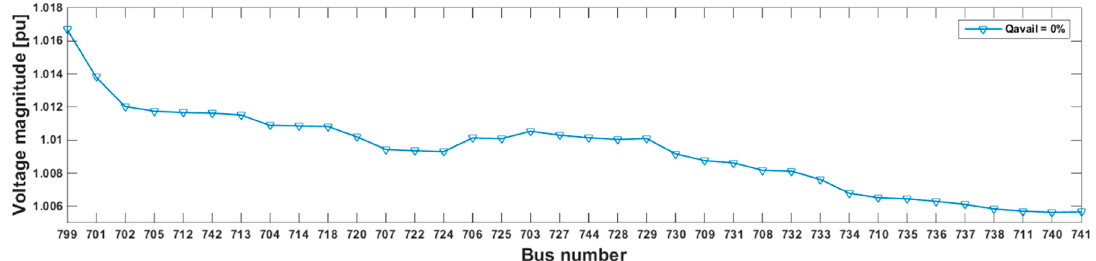
Figure 7. Voltage profiles for light load condition while all DG units output zero power.